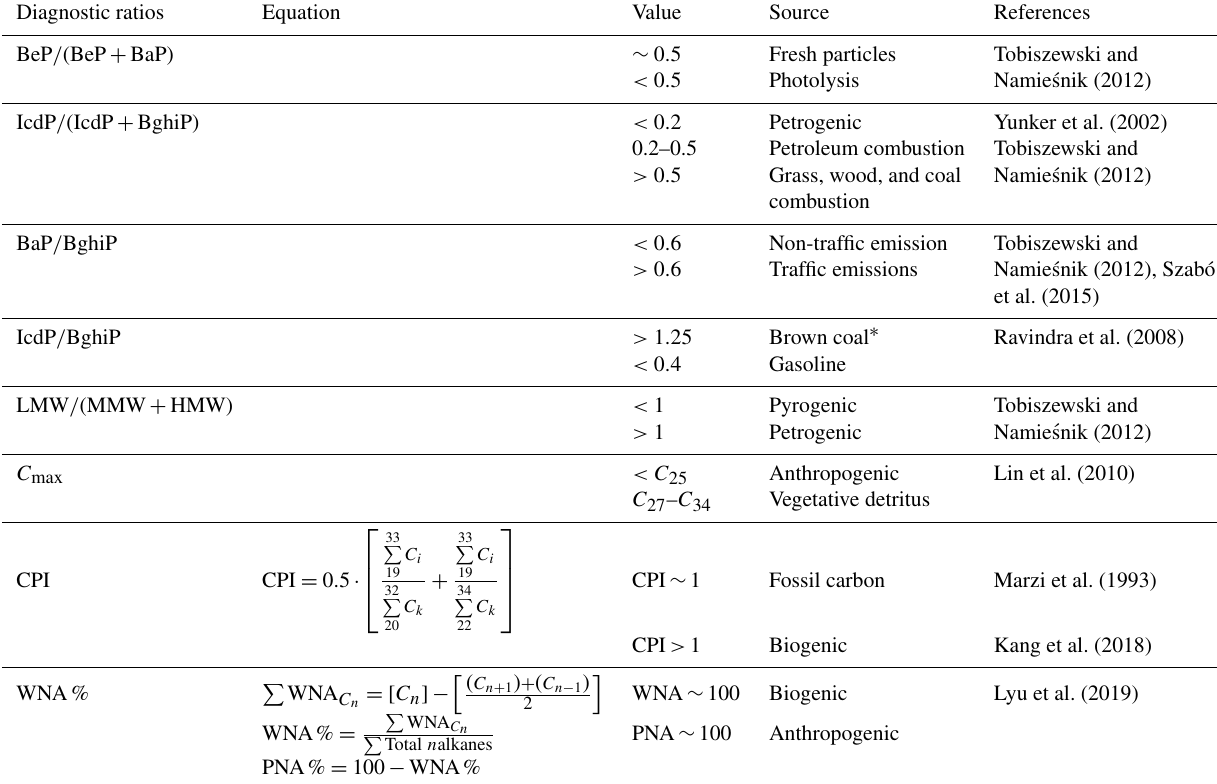
Table 2. Diagnostic ratios of organic compounds used to infer the sources of PM 2 . 5 in this study. Diagnostic ratios Equation